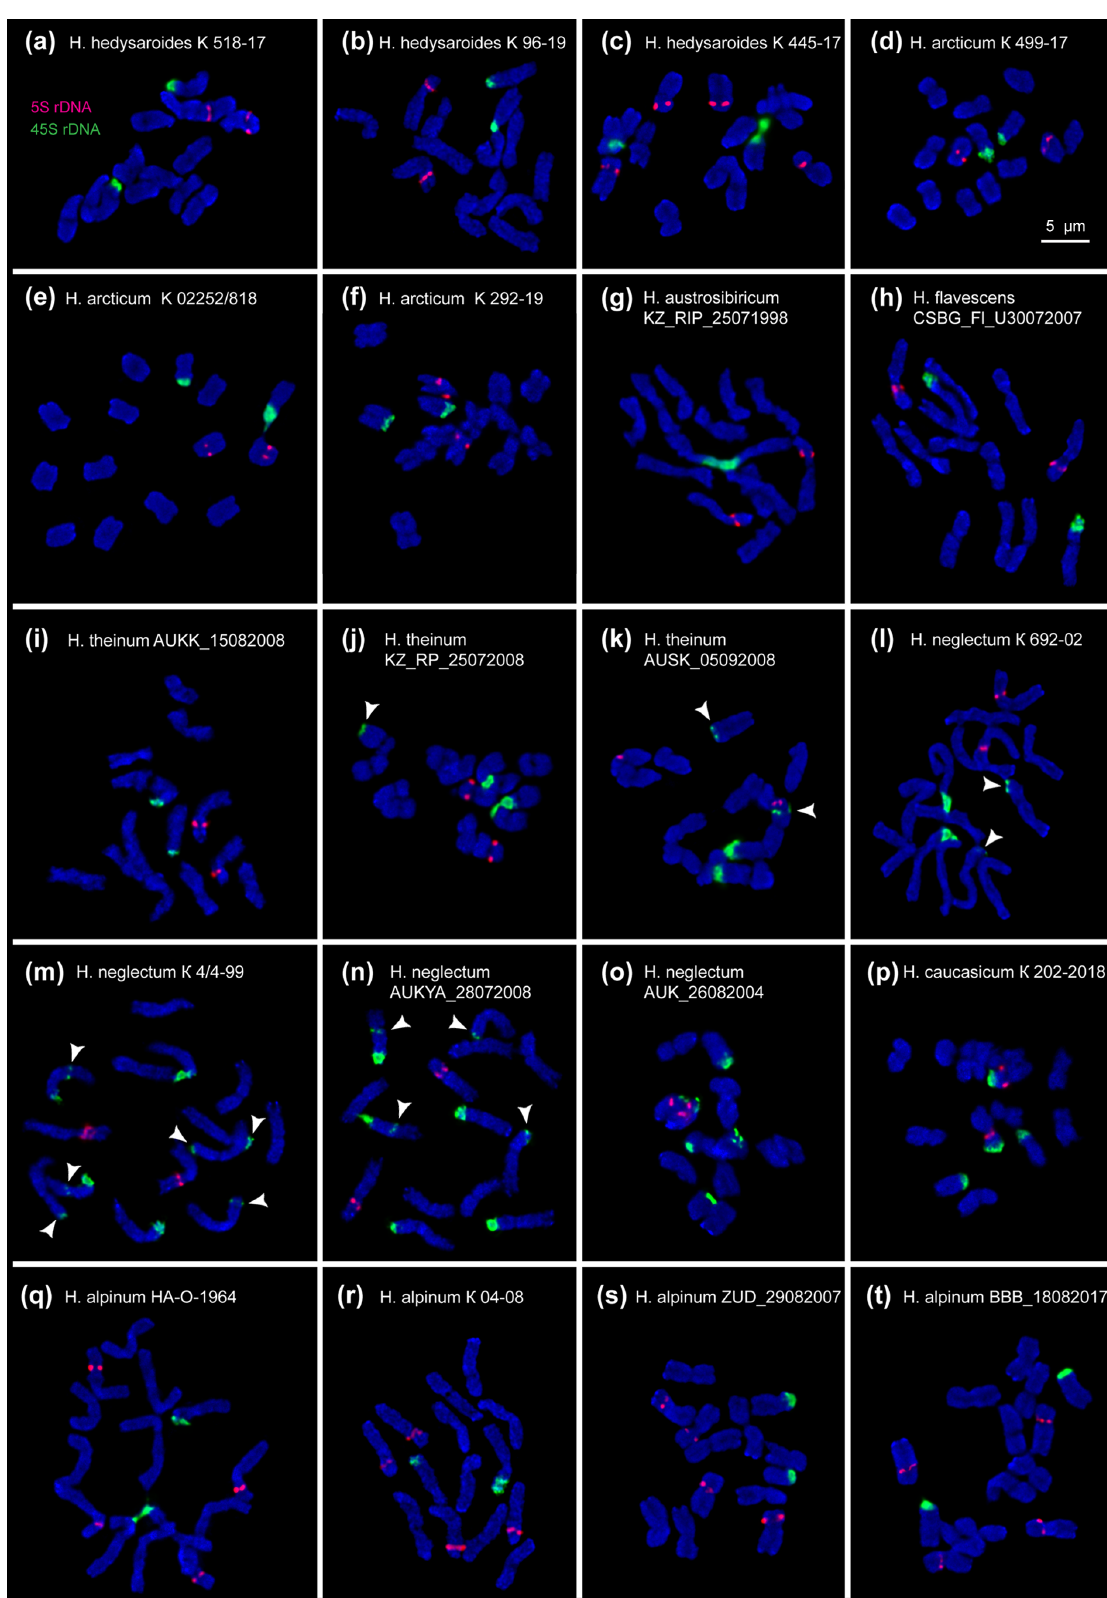
Figure 3. Metaphase plates of the studied accessions of H. hedysaroides ( a – c ), H. arcticum ( d – f ), H. austrosibiricum ( g ), H. flavescens ( h ), H. theinum ( i – k ), H. neglectum ( l – o ), H. caucasicum ( p ) and H. alpinum ( q – t ) after FISH with 45S rDNA (green) and 5S rDNA (red). DAPI chromosome staining—blue. Arrowheads point to polymorphic sites of 45S rDNA. Bar—5 µ